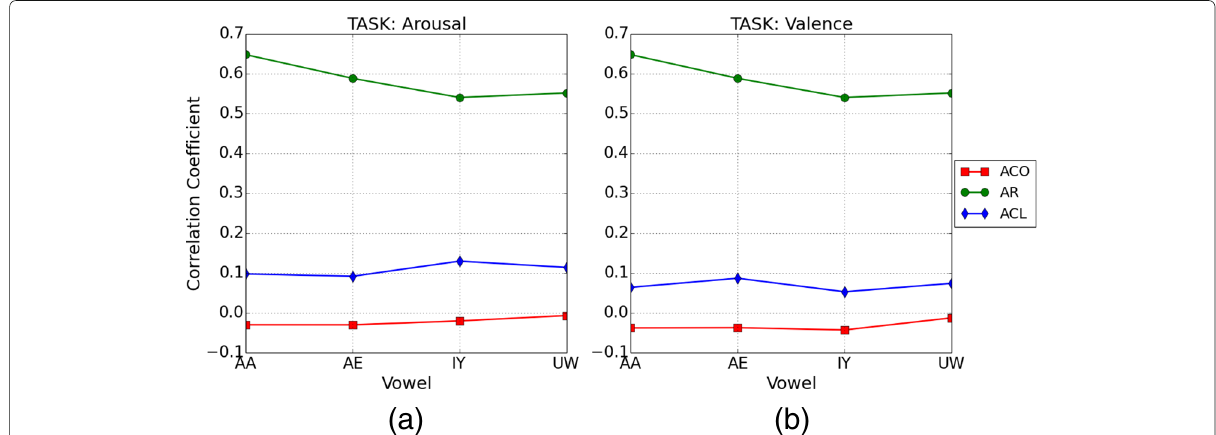
Fig. 7 A comparison of the average correlation coefficient over all articulatory targets and speakers under different training criteria for the USC IEMOCAP